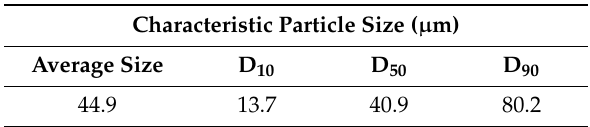
Figure 7. The particle size distribution of the CRFA powder with a particle size of smaller than 0.080 mm. Table 4. The characteristic particle sizes of the CRFA powder.